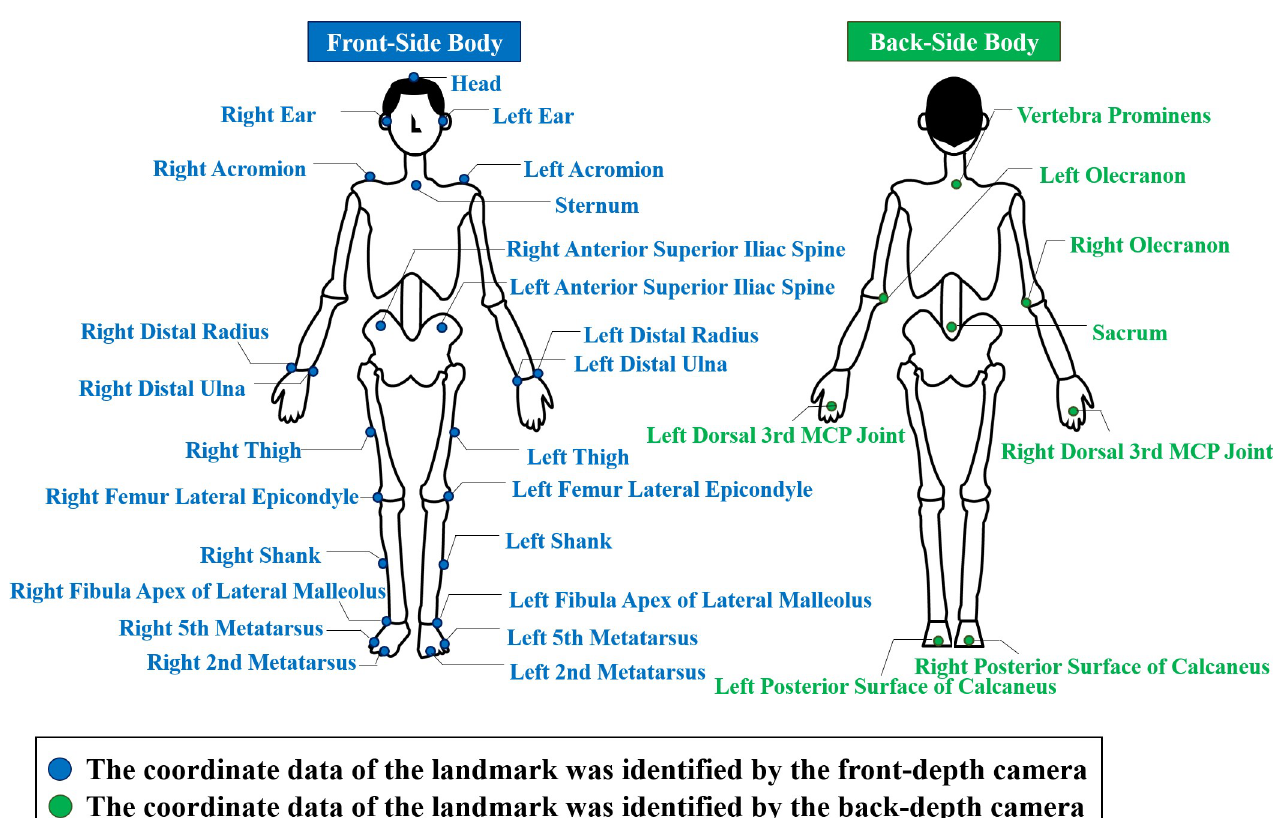
Fig 6. The target anatomical landmarks in this